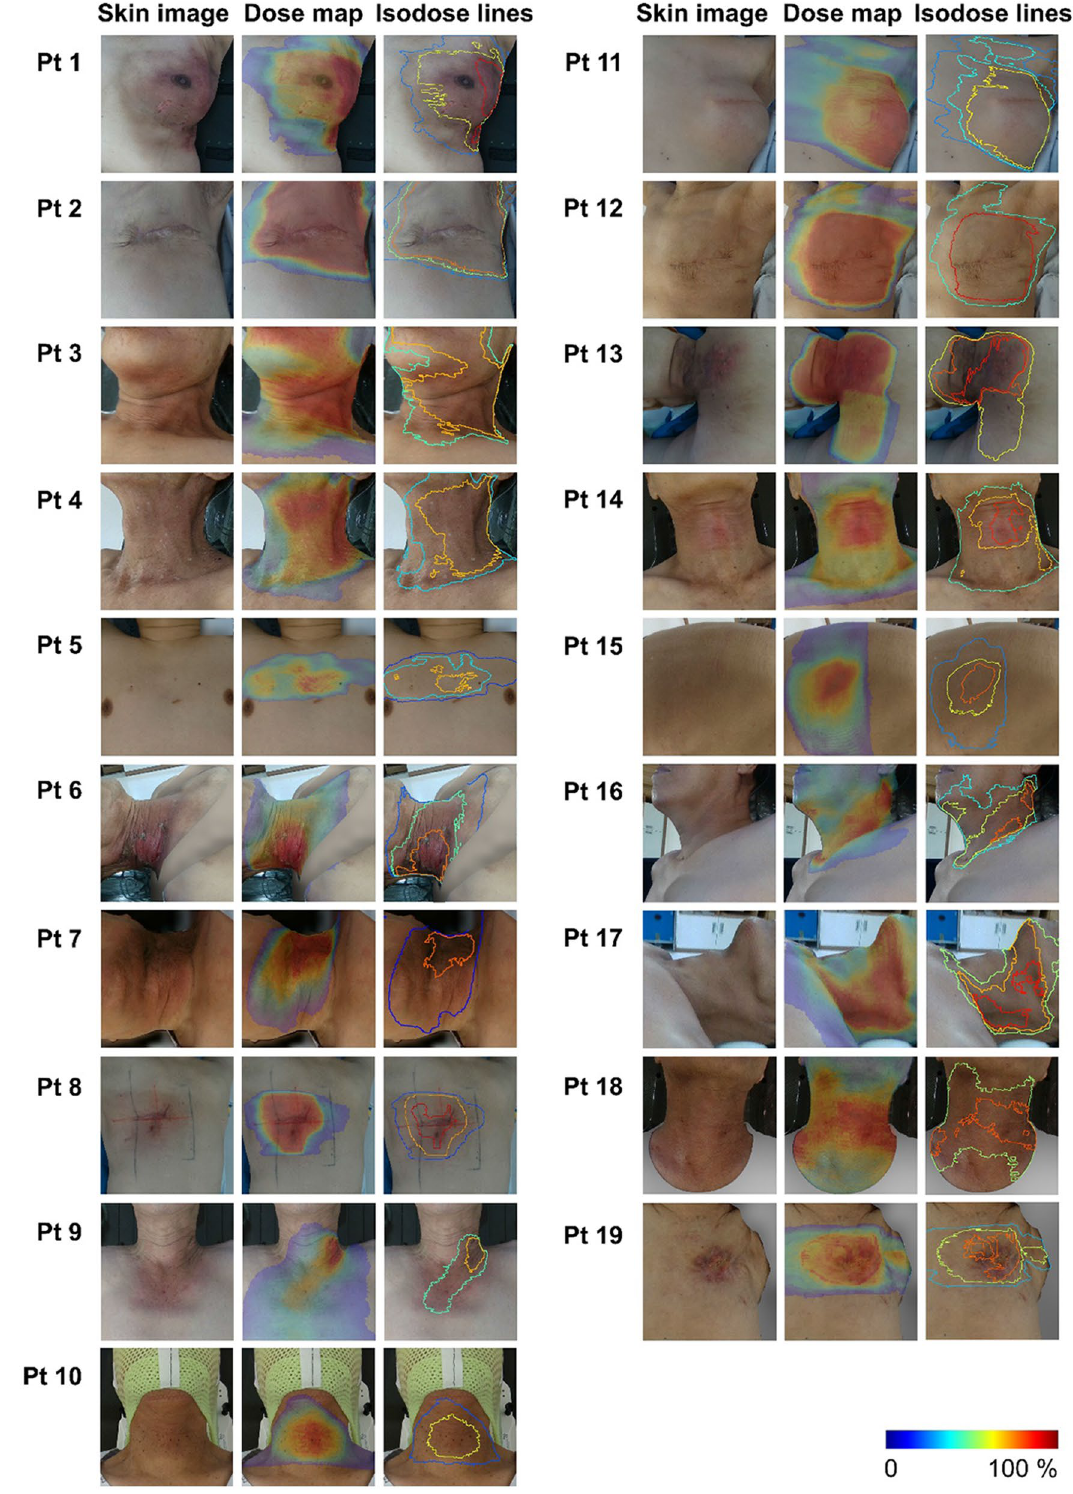
Figure 1. Visualized dose distribution on the skin surface image of radiation dermatitis in 19 patients who underwent radiotherapy. Dose distribution map and isodose distribution are overlapped on patient’s skin image as accumulated dose values up to the time of the 3D scan. The visualized dose map has relative color scale in each patient within dose range exceeding 5 Gy. The isodose curve corresponds to the nearest dose values from the border of radiation dermatitis in each